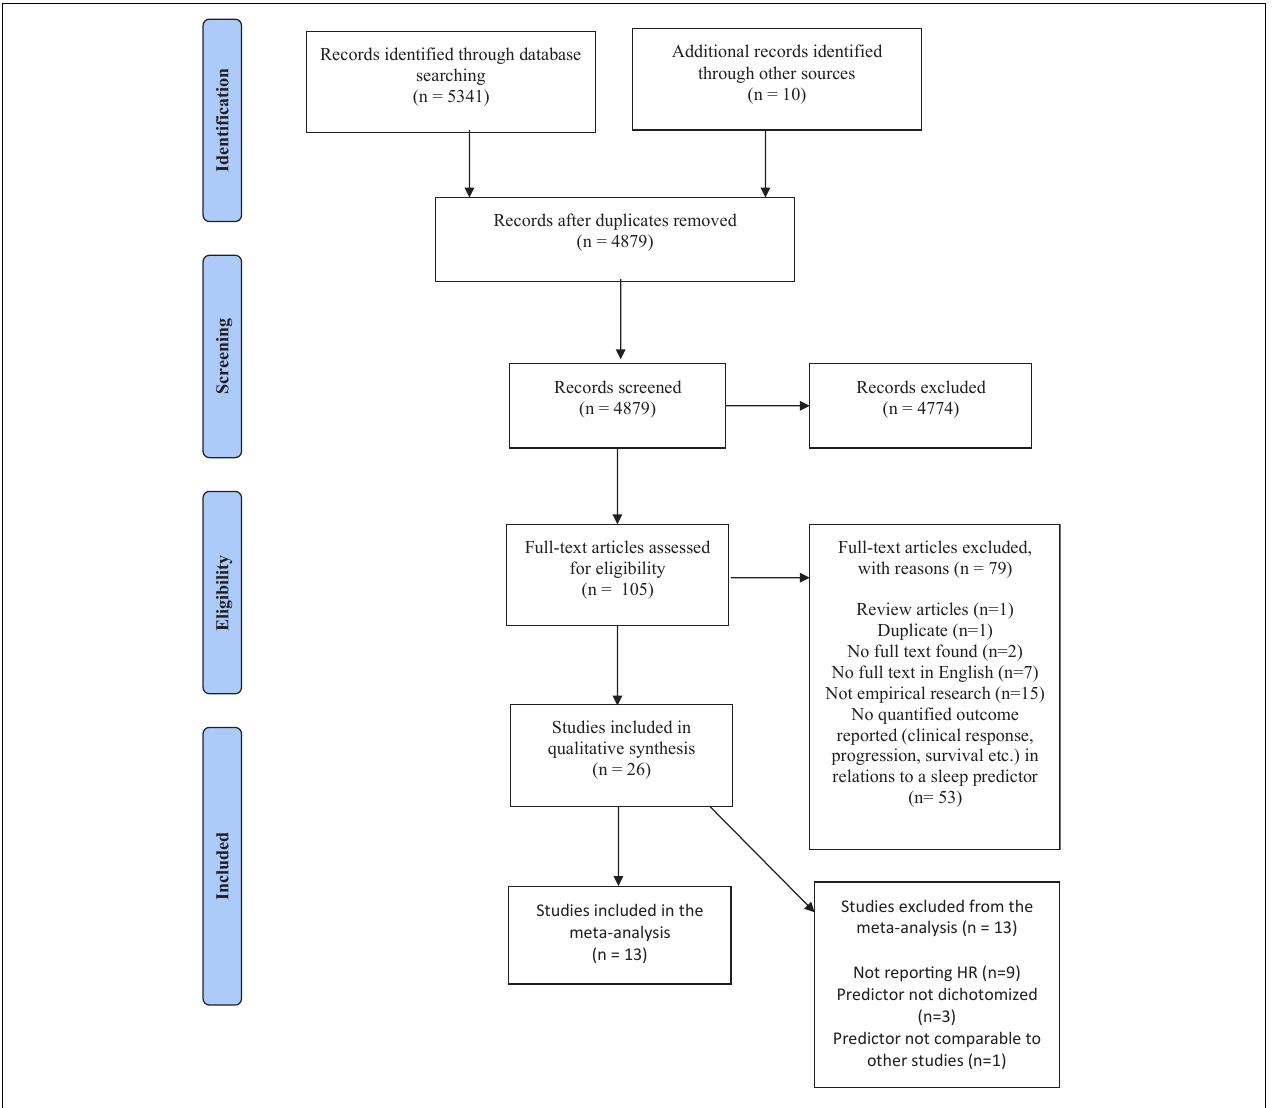
FIGURE 1 | PRISMA flow